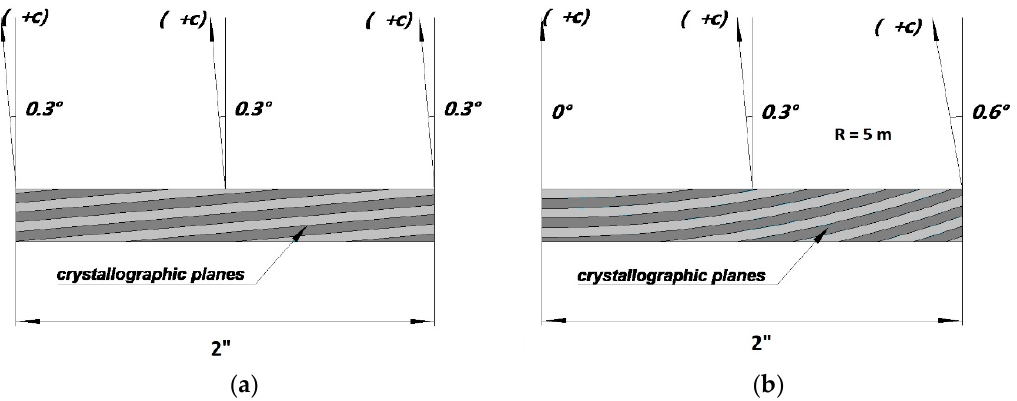
Figure 2. Scheme of GaN substrates with two kinds of (0001) crystallographic planes: ( a ) flat; ( b ) bent. Electronics 2020 , 9 , x FOR PEER REVIEW